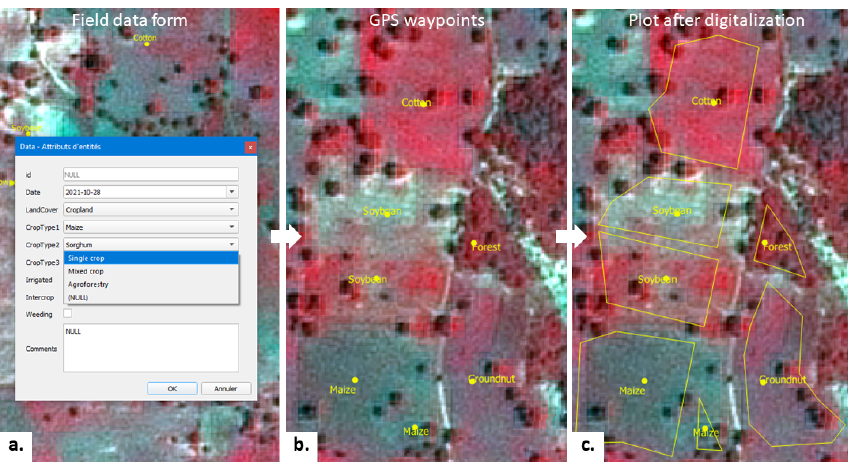
Figure 3. Workflow of the data acquisition: (a) field data form used on the GPS tablet; (b) GPS waypoints acquired in the field and (c) corresponding plots after digitalization of the boundaries, displayed on a satellite image in false color (red: near-infrared band, green: red band, blue: green band). Table 2. Synthetic view of the final GIS